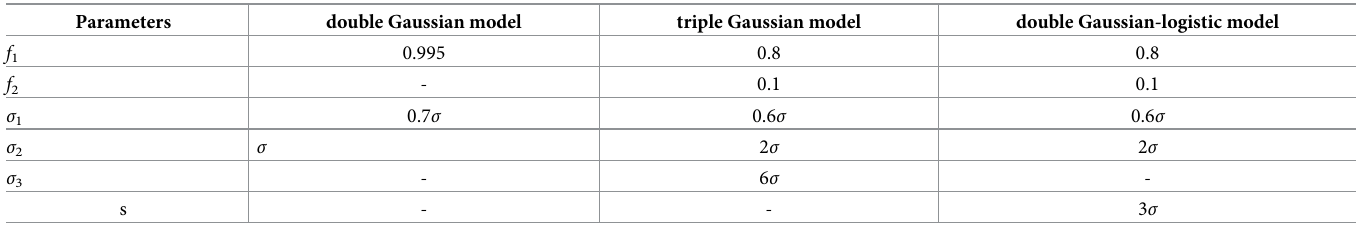
Table 1. The initial values for all